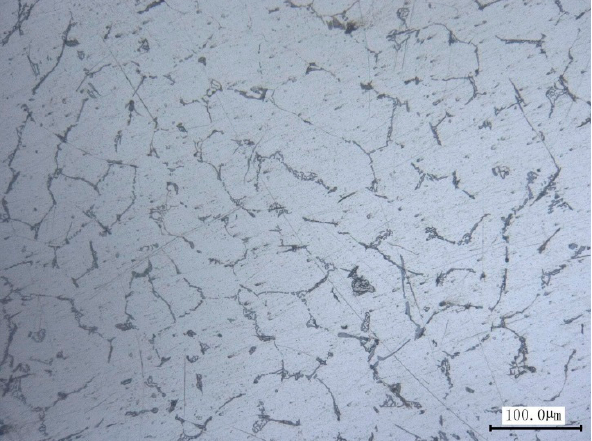
Figure 1. Metallographic image of the polycrystal aluminum. Table 1. Chemical compositions and mechanical properties of polycrystalline aluminum.